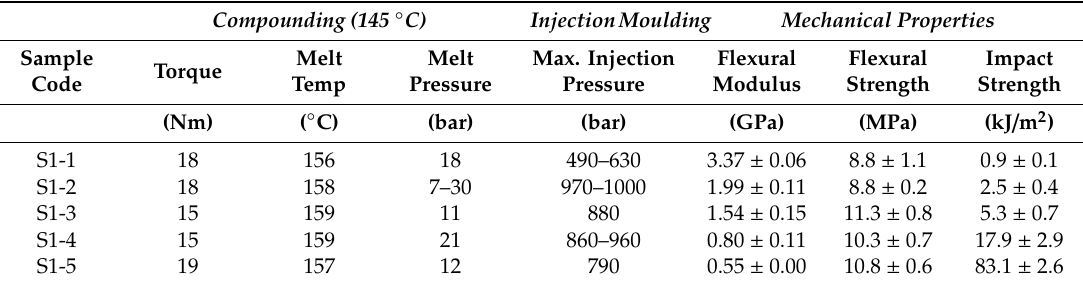
Table 2. Recorded processing parameters for the compounds, and mechanical properties of the green bodies of Series